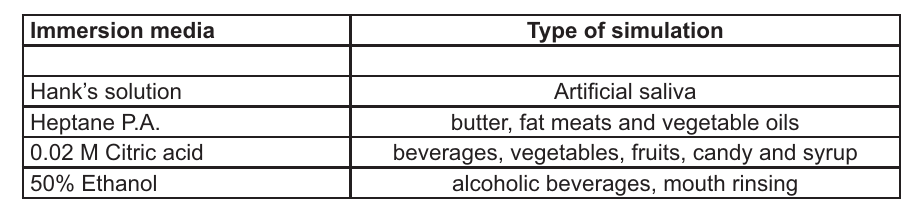
Figure 2- Food-simulating liquids